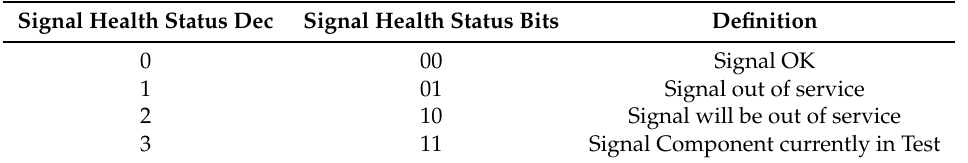
Table 2. Signal status bits definitions [18].